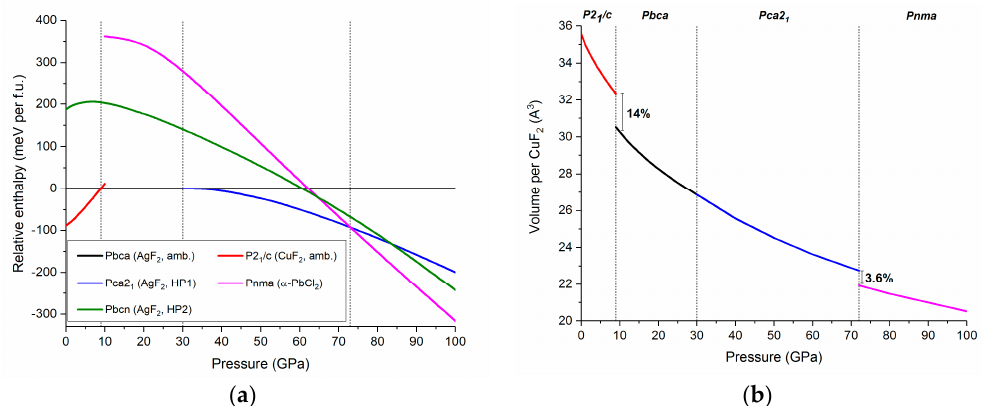
Figure 6. ( a ) The pressure dependence of the relative enthalpies (referenced to that of Pbca ) of various CuF 2 high-pressure polymorphs; and ( b ) the pressure dependence of the volume per one CuF 2 unit. Dotted lines mark P2 1 / c → Pbca , Pbca → Pca2 1 , and Pca2 1 → Pnma phase transition predicted at 9, 30, and 72 GPa, respectively.